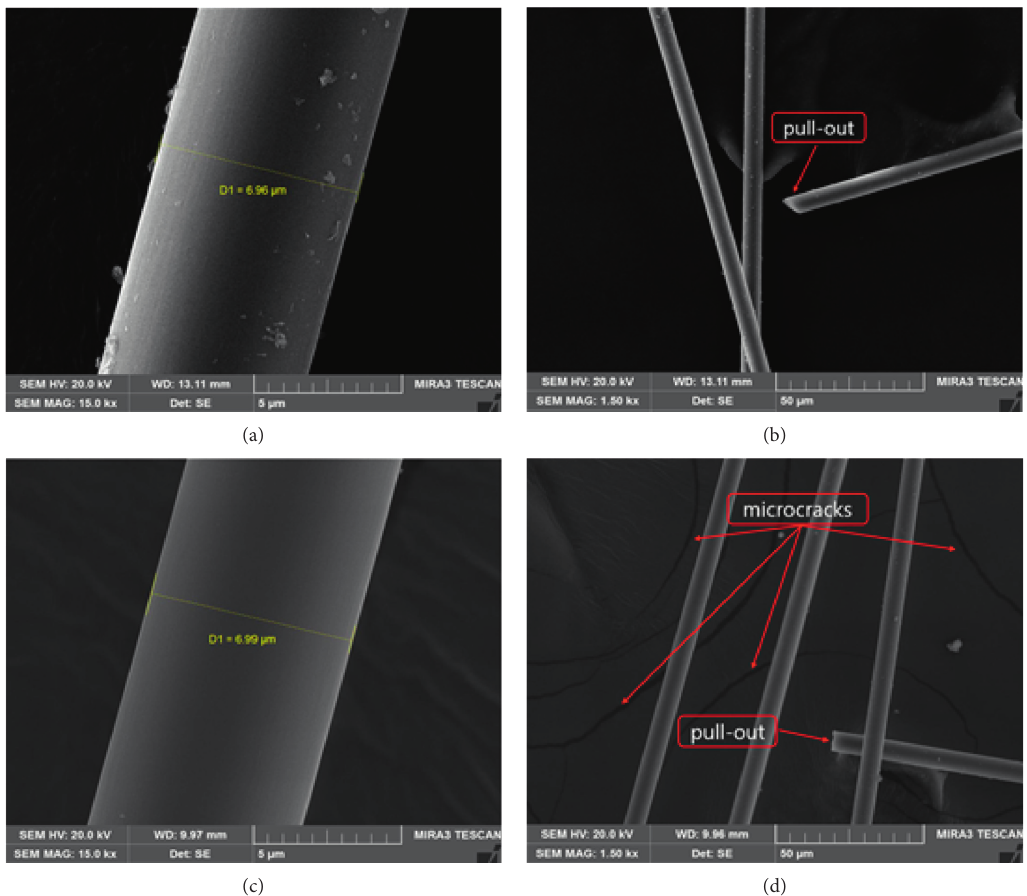
Figure 14: SEM images of the carbon fiber in the cement paste matrix after the pull-out test (15,000 or 1,500x). (a, b) Plain carbon fiber with 10 wt.% SF. (c, d) Plain carbon fiber without